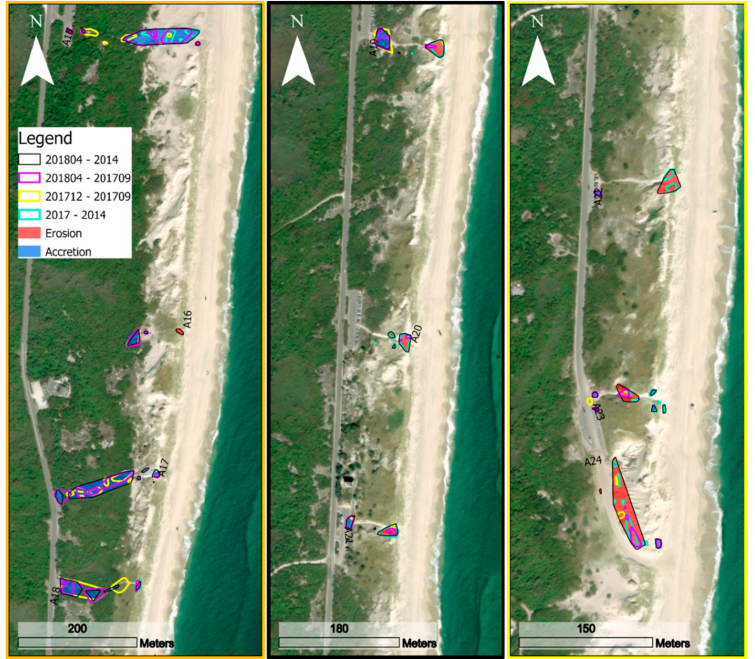
Figure 8. Beach access path impact geometries from 2014 to April 2018. Outlines indicate identified areas of increased elevation change greater than 1 standard deviation of the average elevation change for the difference surface. Red and blue shading indicates categorical elevation change type for whole study period of April 2018–2014. The left map (orange outline) is the northern most section, the center map (black outline) is the central access paths, and the right map (yellow outline) is the most southern access